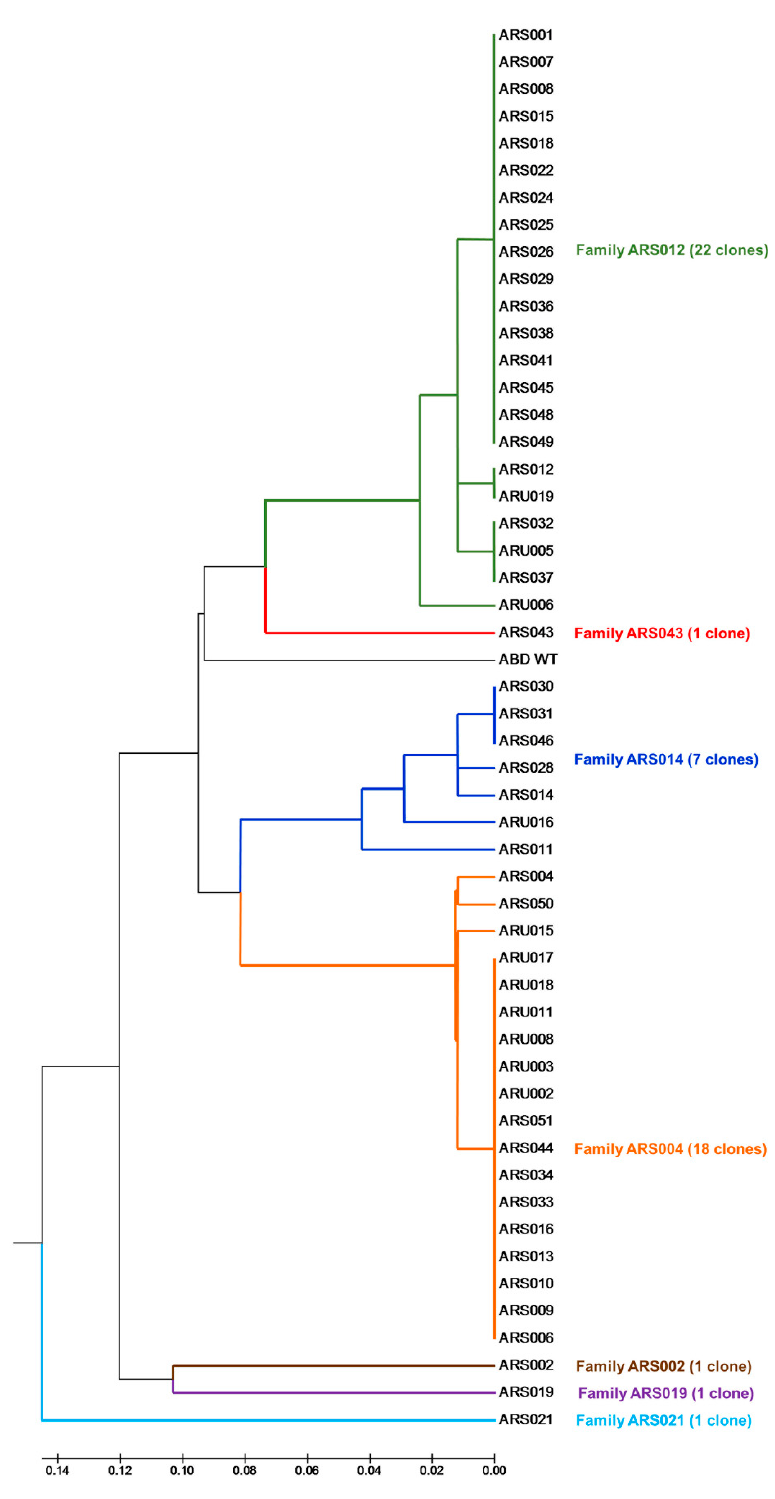
Figure 2. Comparison of a sequence similarity of the selected ARS and ARU clones. Similarity tree of polypeptide sequences of 51 analyzed ARS and ARU variants that were targeted to the recombinant extracellular IL-17RA receptor and selected by ribosome display. Sequence analysis of the ARS/ARU binders revealed 17 unique sequence variants that were clustered into 7 sequence families. For a similarity analysis, only the sequences between residues 20 and 46 were compared, as the N-terminal amino acid positions 1–19 were non-randomized.